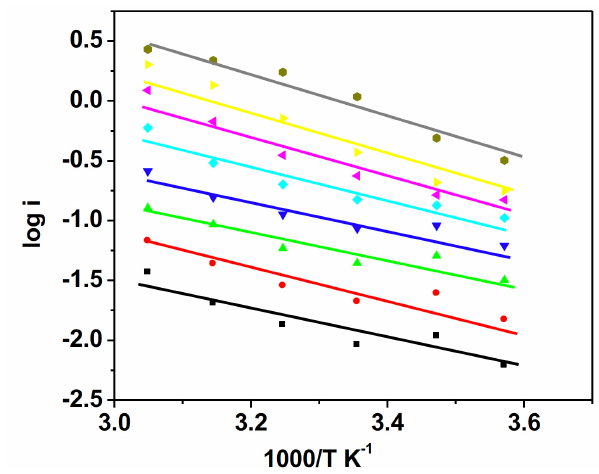
Figure 5. Arrhenius plots of Pd NPs electrode for Methanol Oxidation Reaction